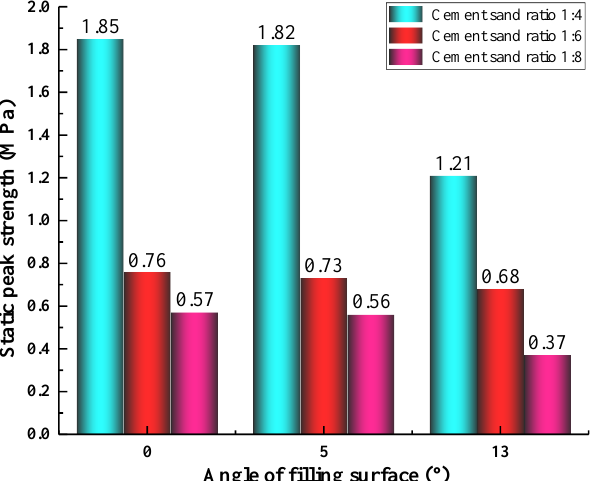
Figure 12. Relationship between the angle of the filling surface and the static peak strength.